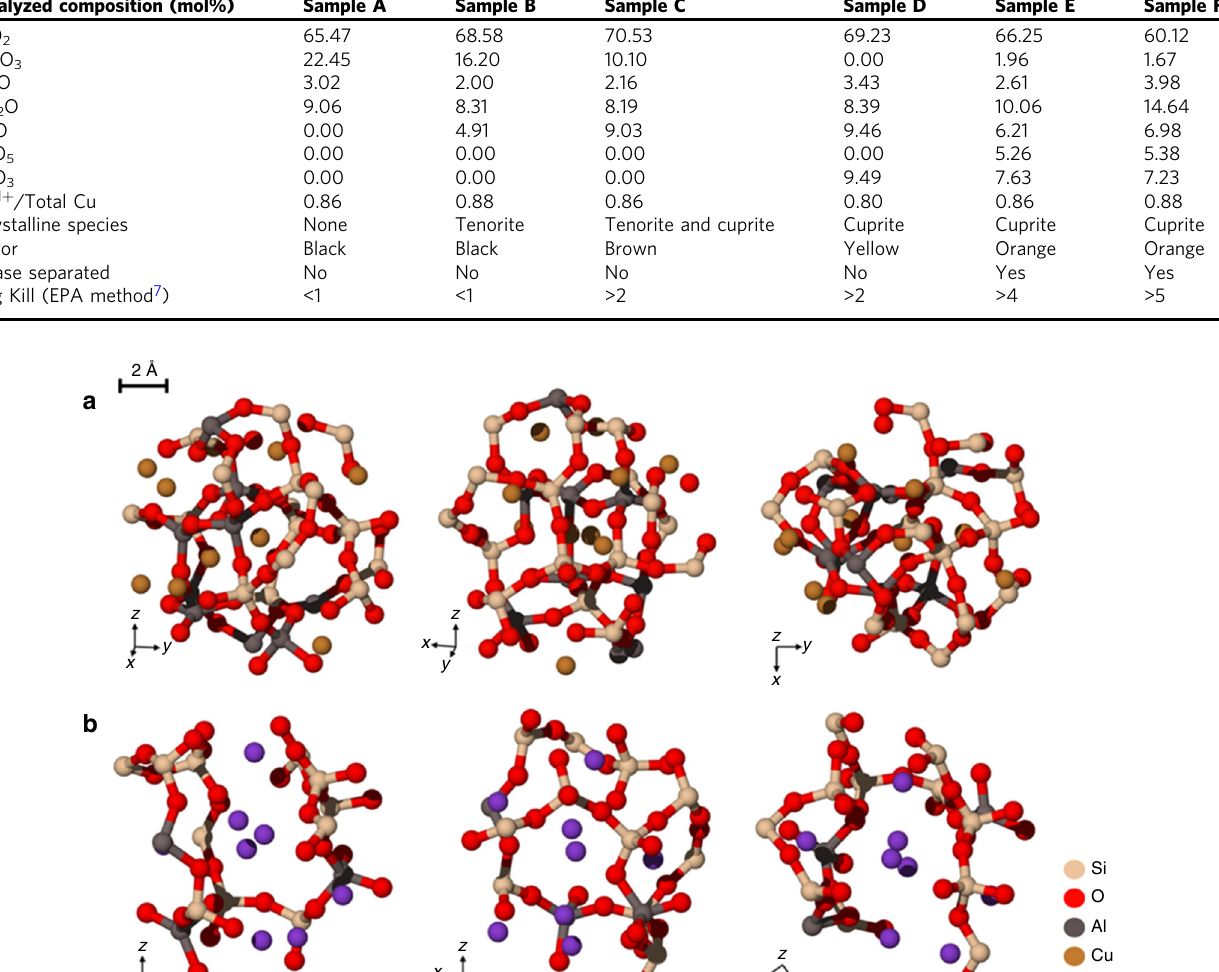
tional access to cuprite crystals. Figure 3 is a scanning transmission electron microscopic (STEM) image of the material: the darkest region is the continuous glassy phase, the next lighter regions are the discontinuous glassy regions, and the brightest regions are the faceted cuprite crystals. Composition mapping by electron-dispersive spectroscopy (EDS) shows that the contin- uous glassy matrix phase is composed primarily of silica while the discontinuous phase containing the cuprite crystals is enriched in phosphorus, boron, and potassium. The dissolution of the discontinuous phase was further proven by analysis of the leached ions measured by ICP-MS. High concentrations of potassium, phosphorus, and boron were observed; conversely, Al ions, presumably present in the silica-rich continuous phase, were present at very low concentrations (Supplementary Table 1).